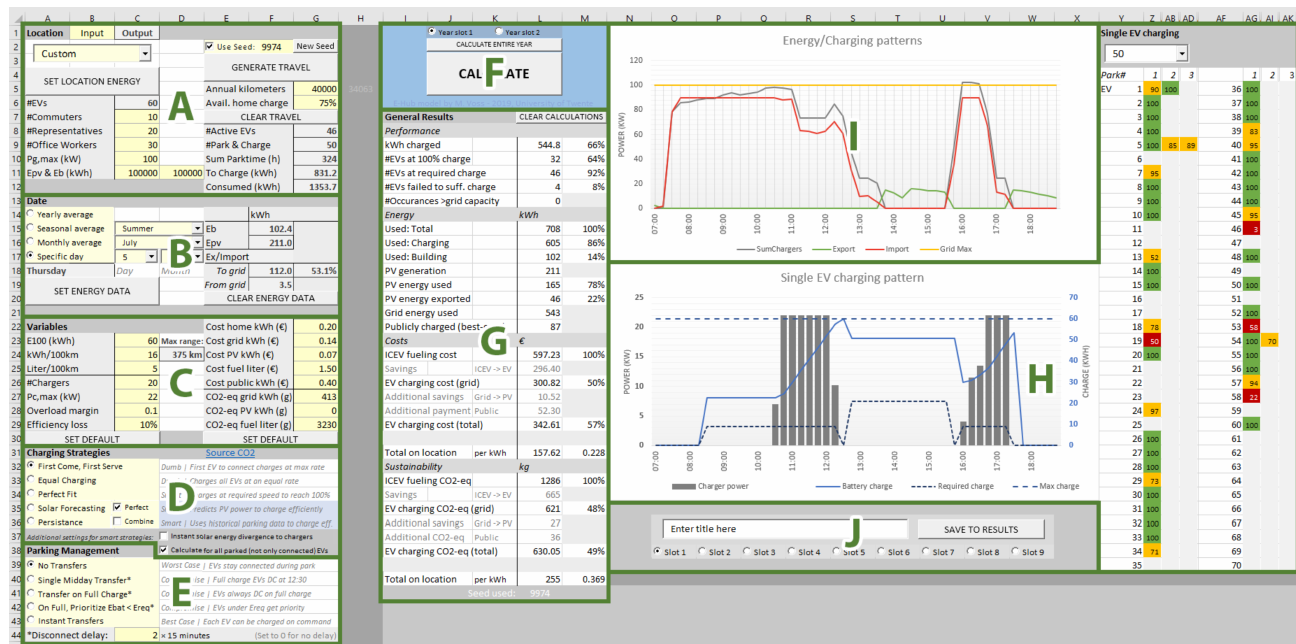
Figure 9. User Interface of the Vehicle Charging Simulation model (VeCS) within Microsoft Excel. The parts are as follows: ( A ) General input including company location size and travel parameters. Note the button to generate travel data. Furthermore, note the seed for reproducible random data generation. ( B ) Date/period selection. ( C ) Variables on energy consumption and price. ( D ) Charging strategy selection (see Section 5.1). ( E ) Parking/connection management strategy selection (see Section 5.2). ( F ) The button to start the simulations. ( G ) Results in numbers. ( H ) Left, graph with single-day charge behaviour for a single (selected) EV, and right, overview with single day results for all simulated EVs: green, fully charged; yellow, partially charged but sufficient for the next trip; red, insufficient charge. ( I ) Overall power use. ( J ) Save results.